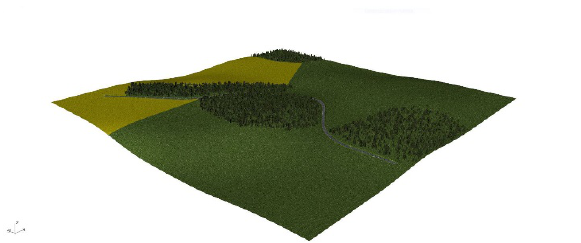
Figure 9. Final 3D model.